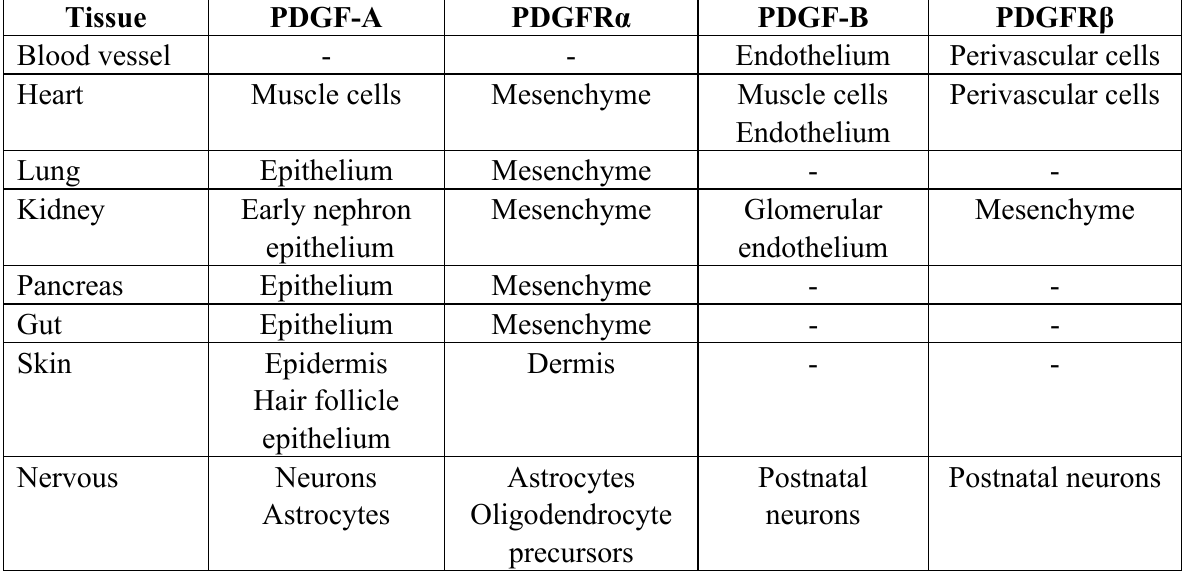
Table 1. Distribution of PDGF and PDGFR in normal human